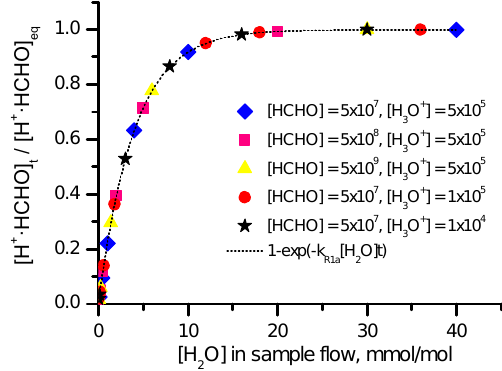
Fig. 1. Concentration of product ions H + · HCHO as a function of reaction time for different scenarios. For all runs: [HCHO] = 5 × 10 7 molecules/cm 3 , [H 3 O + ] = 1x10 4 ions/cm 3 (Steinbacher, 2004). Crosses correspond to the case when only the for- ward R1 reaction is considered and k R1a is set to zero. Cir- cles ([H 2 O] = 1.5 × 10 15 molecules/cm 3 ) and triangles ([H 2 O] = 5 × 10 13 molecules/cm 3 ) correspond to the case where both the for- ward and reverse reactions, R1 and R1a, take place. Shaded area represents reaction times typical for the drift tube.